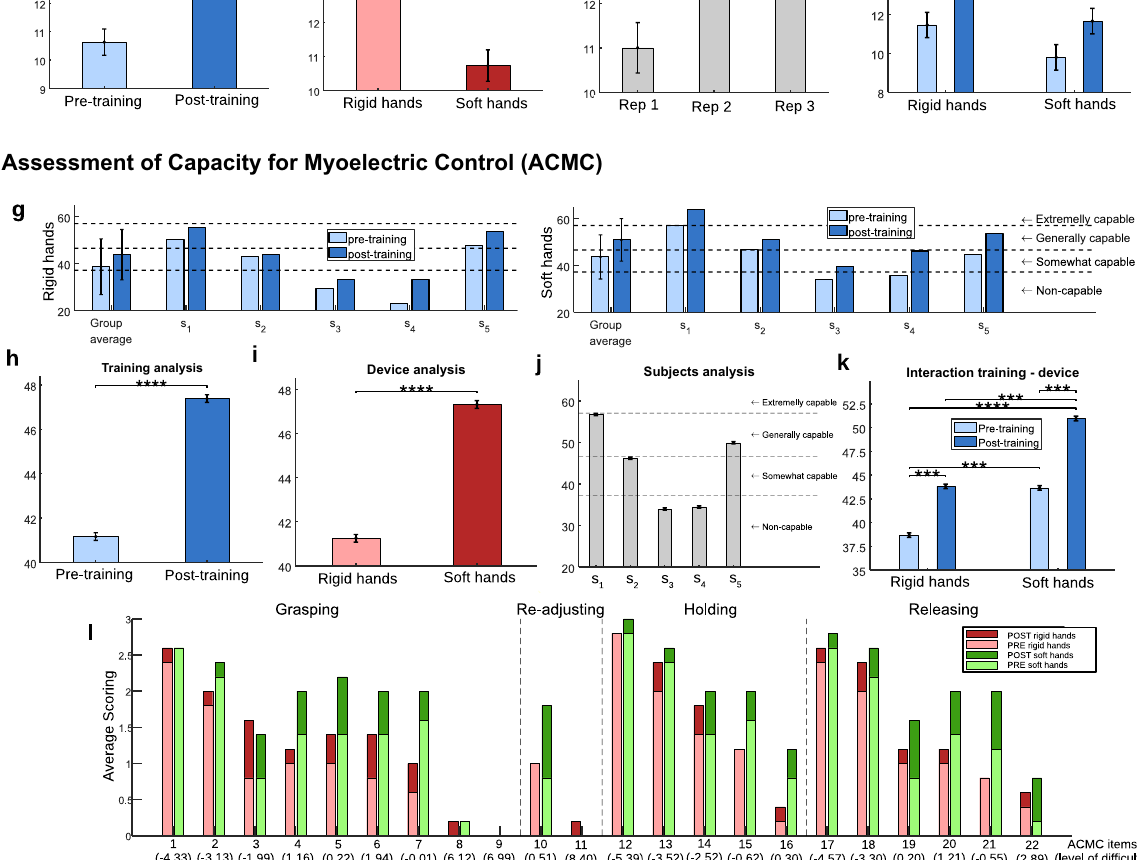
Figure 2. Functional assessment. ( a ) Shows a table with the statistical results for each assessment and factor included. ( b ) BBT score (n = 3 repetitions for each subject s i ). ( c – f ) Present the relation between the factors analysed, including an interaction test between training and the device. ( g ) Shows results of ACMC for each subject and the group average. ( h – k ) Present the relation between the factors analysed, including an interaction test between training and the device. After a post-hoc Tukey test, significance is expressed with asterisks in a GraphPad style among bars, when occurs. P values < 0.001 are summarized with *** and p < 0.0001 is expressed with ****. ( l ) Details the average item score for each hand in pre- and post-training